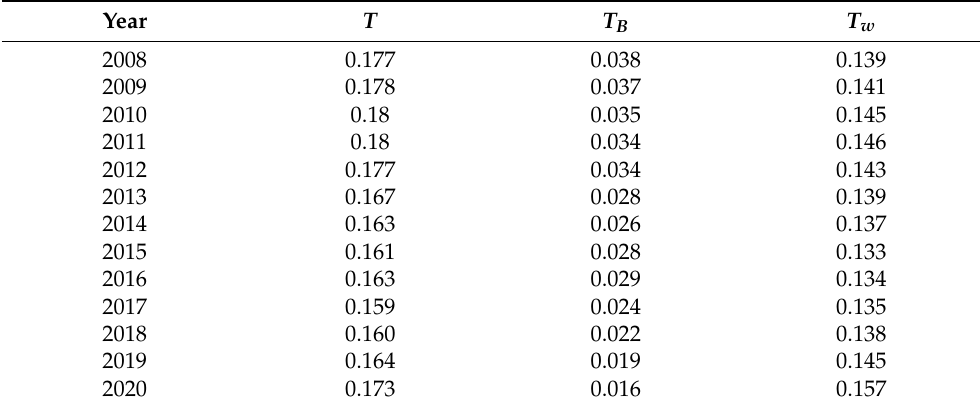
Table 4. Theil index of transportation industry